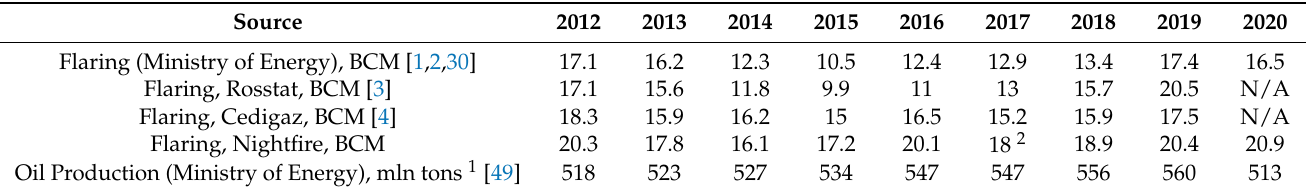
Table 1. Annual APG flaring volumes and oil production levels in Russia.